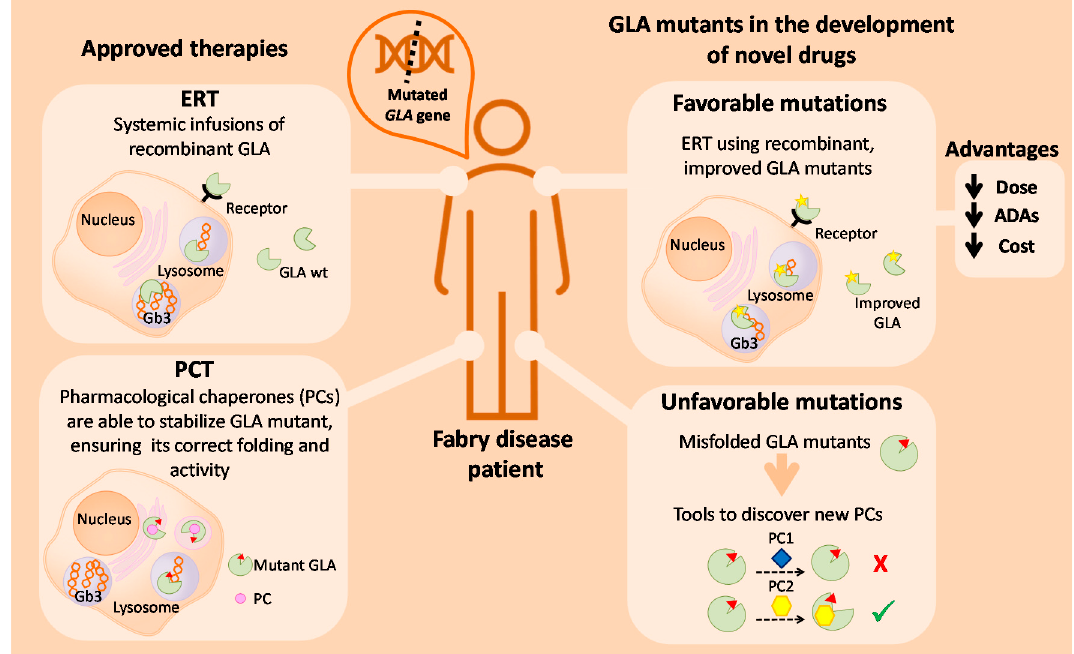
Figure 4. Schematic overview of current therapies for FD treatment, and the putative use of GLA enzyme mutants as tools to develop new therapeutic approaches for FD.